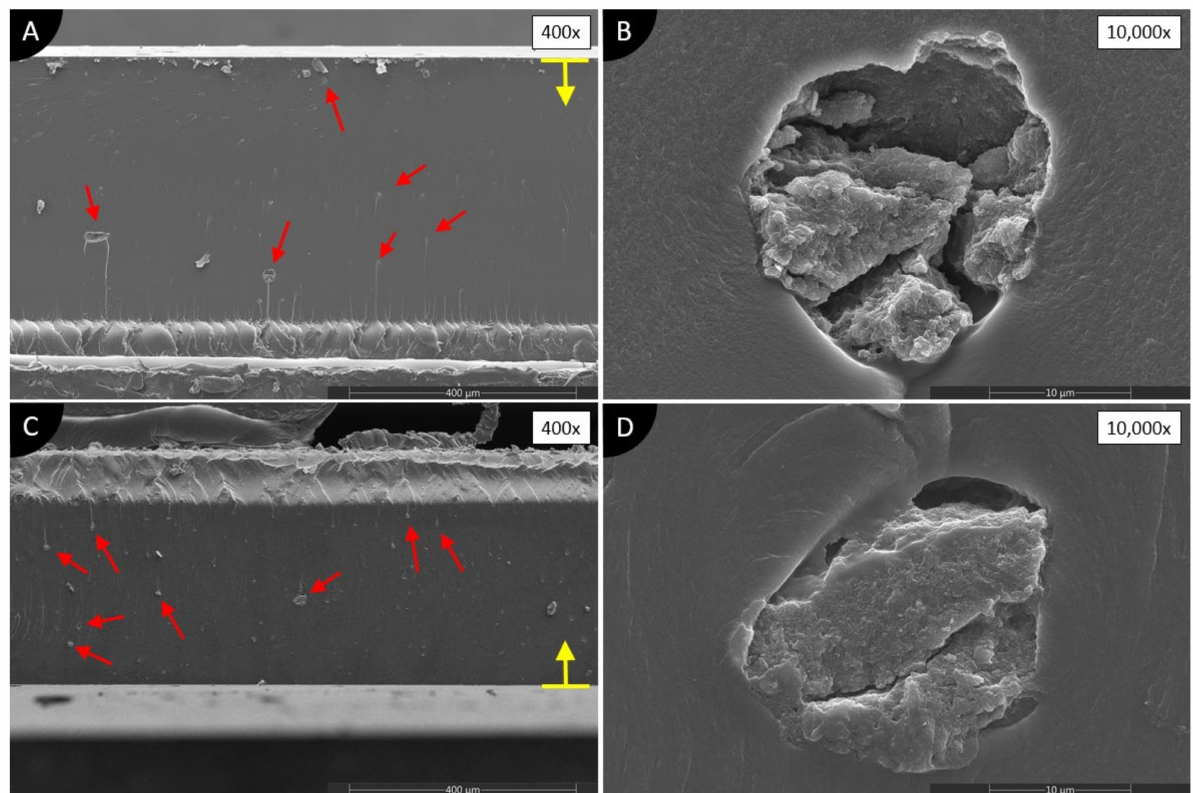
Figure 8. SEM images of cross-sections of 0.1 wt.% GNPs/photopolymer composites dispersed in ( A , B ) acetone; ( C , D ) isopropanol. Red, solid line arrows show agglomerations. A yellow arrow with a line defines the direction of UV light and the surface of the composite on the glass during